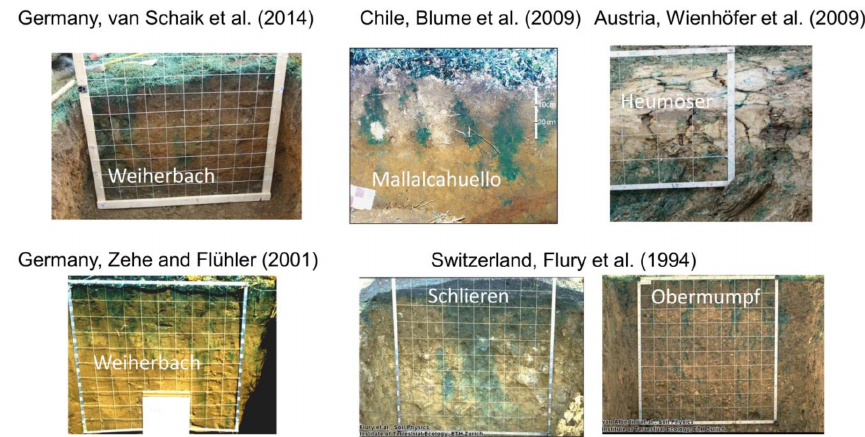
Figure 3. Finger flow pattern revealed from standardized dye staining experiments for a transport time of 1d; images were generously provided by Flury et al. (1994, 1995; © American Geophysical Union 1994, 1995) for Switzerland, Blume et al. (2009, © Theresa Blume) for Chile, Wienhöfer et al. (2009, © Jan Wienhöfer, KIT) for Austria, and Zehe and Flühler (2001, © Erwin Zehe, KIT) and van Schaik et al. (2014, © John Wiley & Sons, Ltd. 2013) for the German